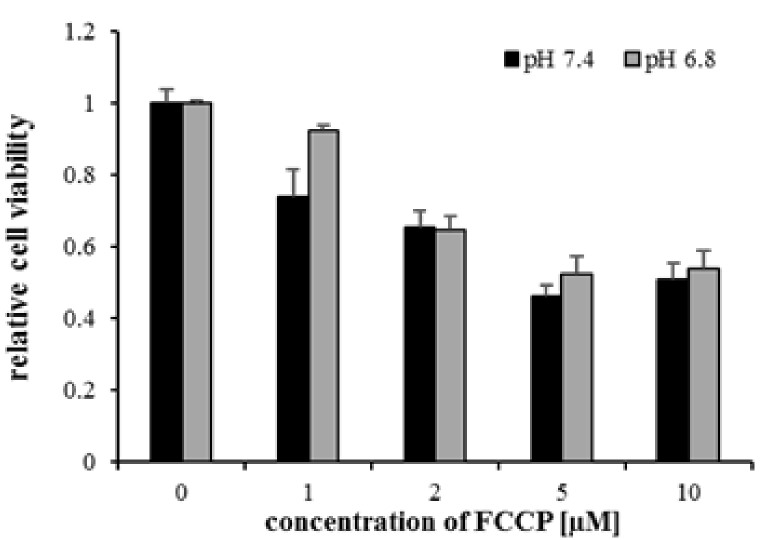
Figure A7. The effect of pH on cancer cell sensitivity to carbonyl cyanide- p -trifluoromethoxy phenyl- hydrazone (FCCP). Viability of PaTu-8902 cells cultured in media with different pH for 72 h and with FCCP for 24 h. Viability was measured by resazurin